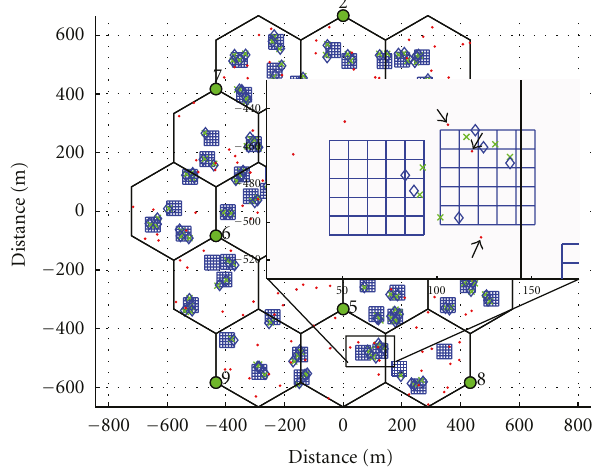
Figure 4: Four apartment blocks and ten macro UEs per macro sector. Macro UEs are denoted by red dots, femto UEs by blue diamonds, HeNBs by green crosses and eNBs by filled green circles, each denoted with a number. The close-up shows a few marked macro UEs undergoing potentially severe downlink interference from nearby active